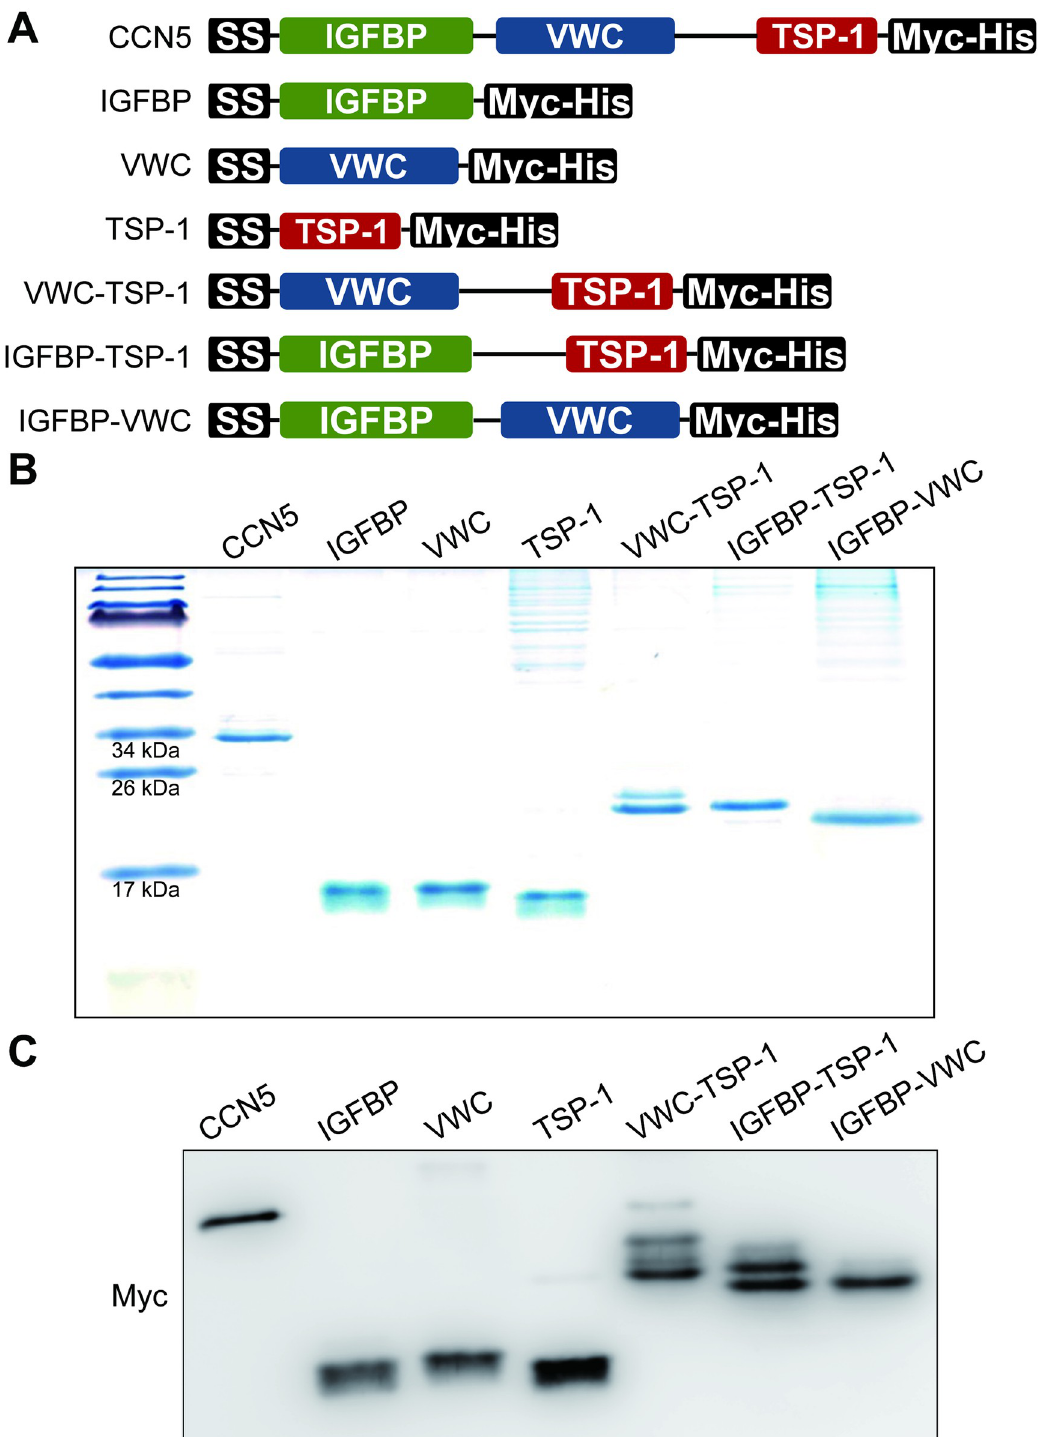
Fig 2. Constructs for the single and paired-domain proteins of CCN5. (A) Constructs for full-length CCN5 and single domain and paired-domain proteins of CCN5 are shown. The constructs were expressed in HEK 293-F cells and the corresponding proteins were purified from culture media using the His tag. The purified proteins (1 μ g) were subjected to SDS-PAGE and stained with Coomassie blue (B). The proteins (200 ng) were also subjected to western blotting with anti-Myc antibody (C).